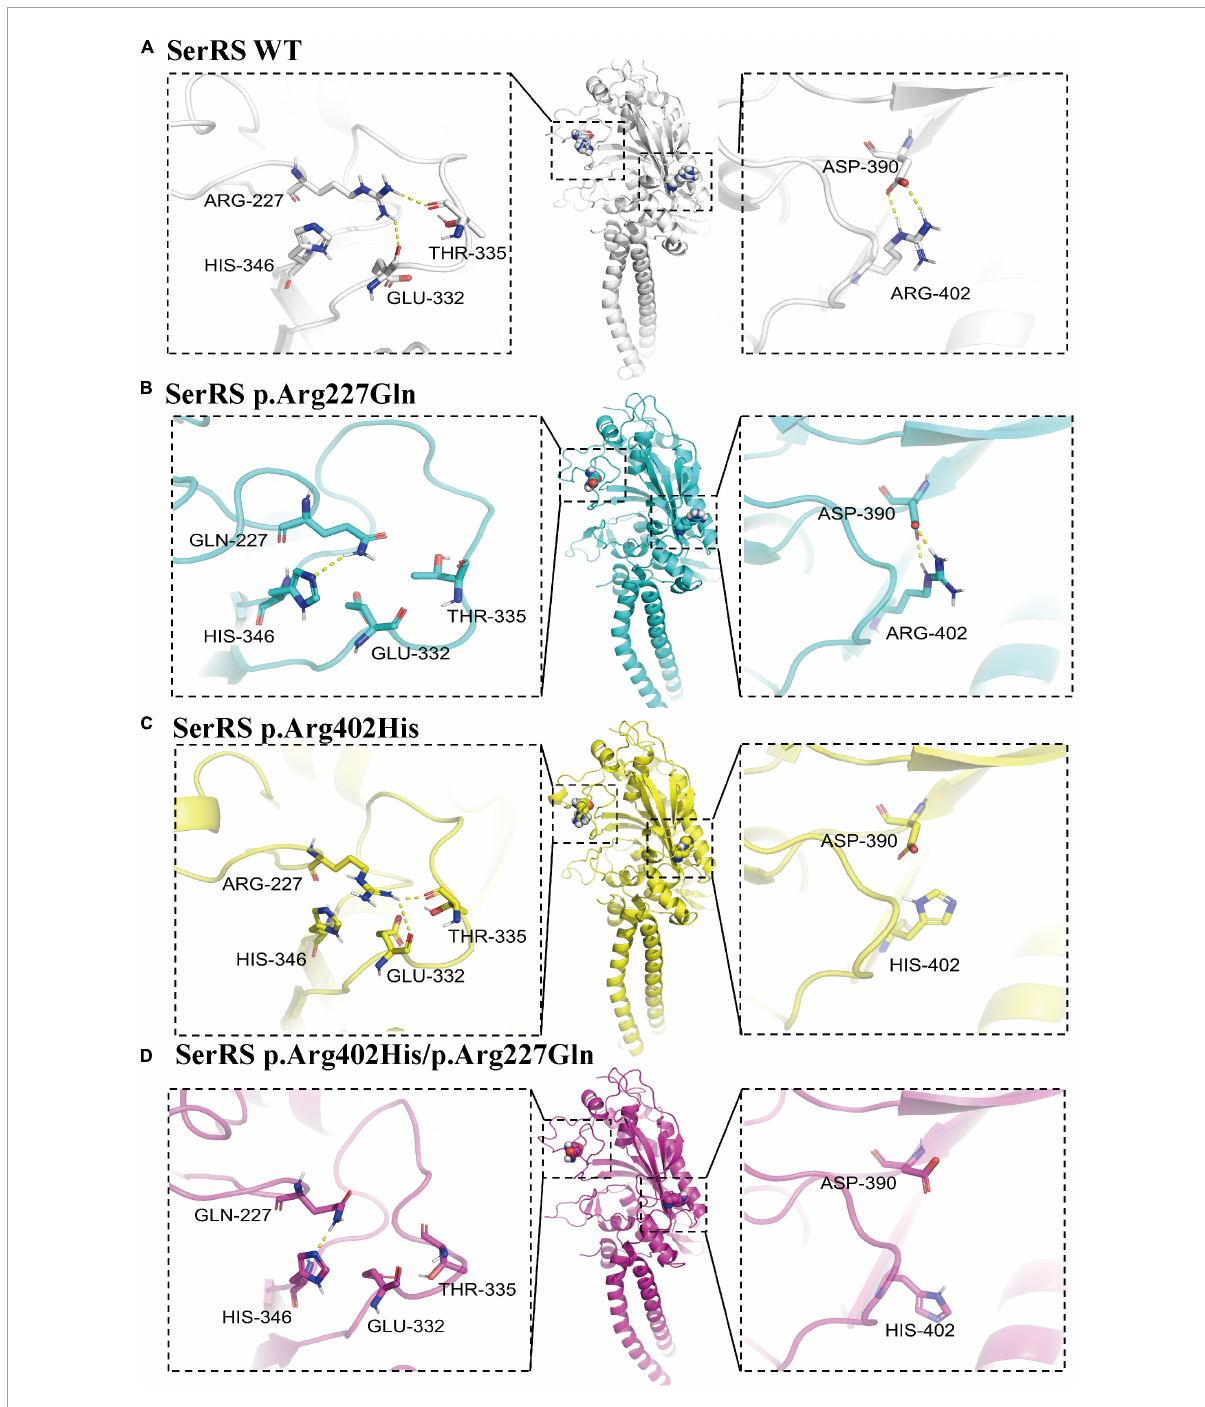
FIGURE3 The structure analysis of SerRS variants using PyMOL 2.5.2, and the structure is optimized by molecule dynamics simulation to acquire the most stable configurations. The hydrogen bonds are marked with yellow dashes. (A) Configuration of SerRS wild type. (B) Configuration of SerRS p.Arg227Gln variant. (C) Configuration of SerRS p.Arg402His variant. (D) Configuration of SerRS p.Arg402His/p.Arg227Gln variants. All variants did not cause significant structure damage to SerRS. However, p.Arg227Gln and p.Arg402His/p.Arg227Gln variants lost the hydrogen bond of Arg-227 with Thr-335 and Glu-332, while acquired the hydrogen bond with His-346. p.Arg402His and p.Arg402His/p.Arg227Gln lost the hydrogen bond and ionic bonds between Arg-402 and